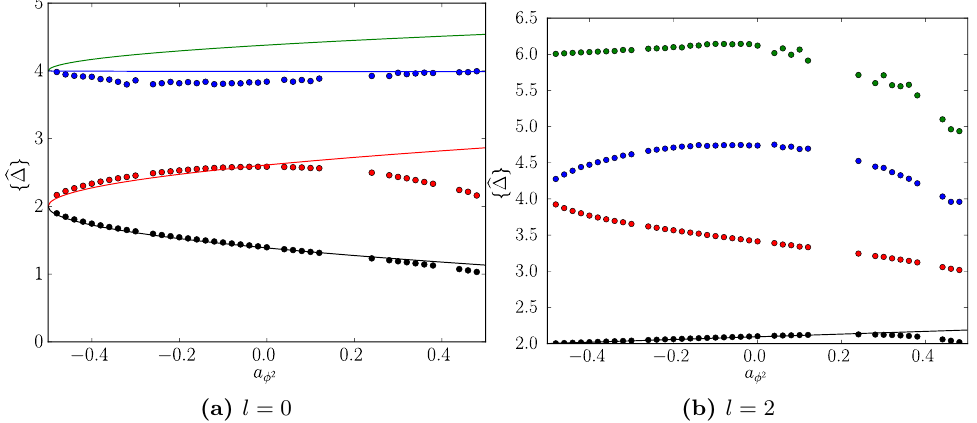
Figure 7. Extremal spectra along the upper branch of figure 4 for unprotected operators of spins 0 and 2. Alongside the data points we have also added perturbative results around the Dirichlet end (as a solid line of the same color) where